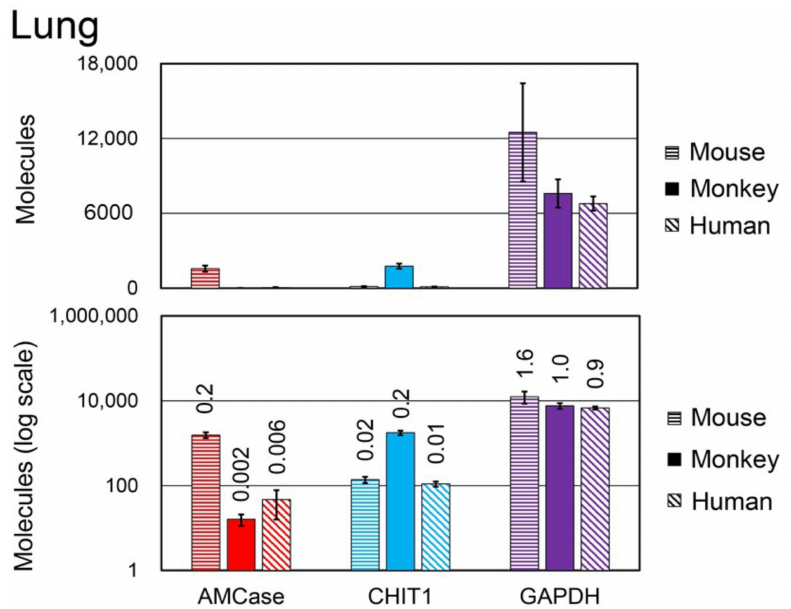
Figure 6. Analysis of the expression levels in monkey, human, and mouse lung tissues. The expression levels of AMCase, CHIT1 , and GAPDH were quantified using qPCR. Horizontal striped bars, mouse; filled bars, monkey; hatched bars, human. The expression level of the monkey GAPDH gene was set to 1.0; the values above the bars indicate the relative expression levels compared with that of monkey GAPDH . Upper panel, actual value; lower panel, logarithmic